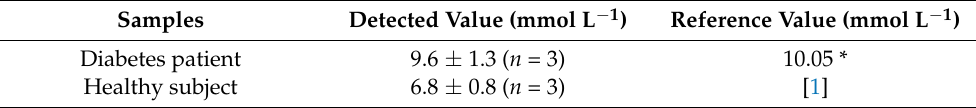
Table 2. Determination of glucose level in a serum sample measured by the MF-iGPE glucose